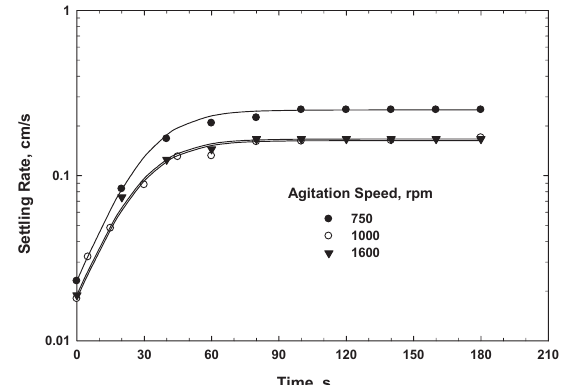
Fig. 6 The effect of agitation speed on floc growth (as represented by settling rate) for kaolin suspen- sions at 3% solids by weight flocculated by con- tinuous nonionic polymer addition at 2 mg/L. min at pH 5. Data of Bunnaul 20) .